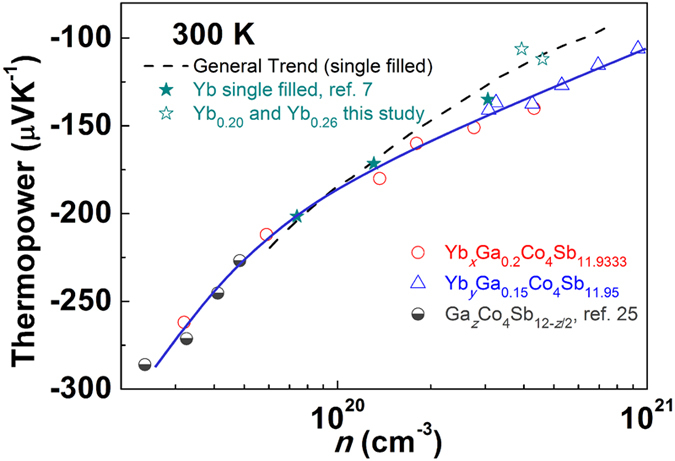
Thermopower values at different carrier concentration levels at 300 K.The dashed line represents the general trend of thermopower taken from the literature for n-type filled skutterudites with different single fillers25. The red circle symbols are YbxGa0.2Co4Sb11.9333 (x = 0, 0.05, 0.10, 0.15, 0.20, 0.26) and the blue triangles are YbyGa0.15Co4Sb11.95 (y = 0.20, 0.25, 0.30, 0.35, 0.40) from this study. The data of Ga-CCCD samples GaδCo4Sb12-δ/3 from ref. 25 is also plotted in the figure. The solid blue line represents the data trend for all the Ga-containing charge-compensated compounds.